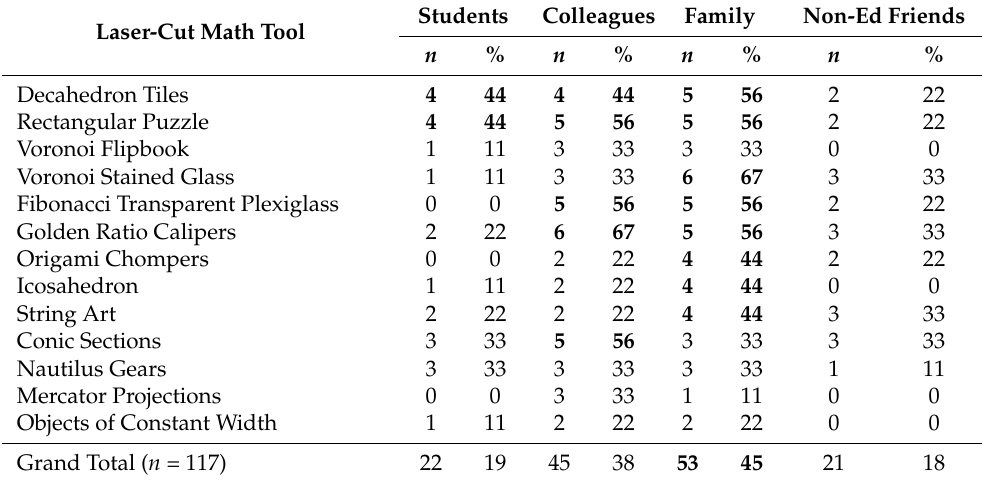
Table 3. Frequencies of in-service teachers’ usage of tools after the workshops ( n = 9). Laser-Cut Math